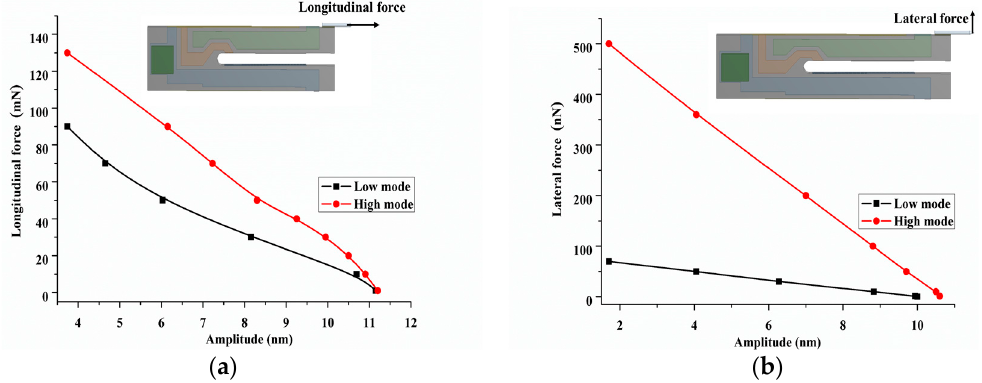
Figure 16. Resonance amplitude of the QTF-p under ( a ) the longitudinal and ( b ) lateral interactions at two modes.